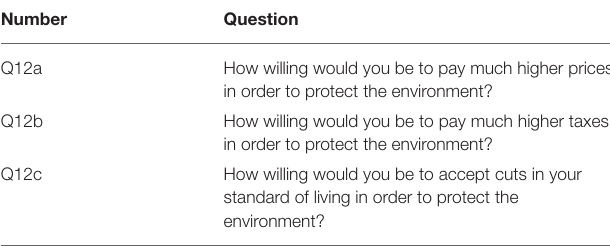
TABLE 1 | Exact wording of the questions in WTS.